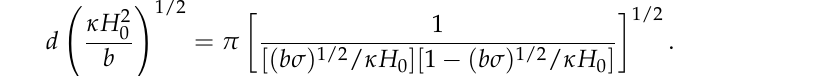
Figure 5. Domain size, d , in units of ( b / κ H 2 κ 2 H 2 / b . The domain size diverges both as the surface tension goes to zero, and also at the Lifshitz line, 0 = b σ / κ 2 H 2 0